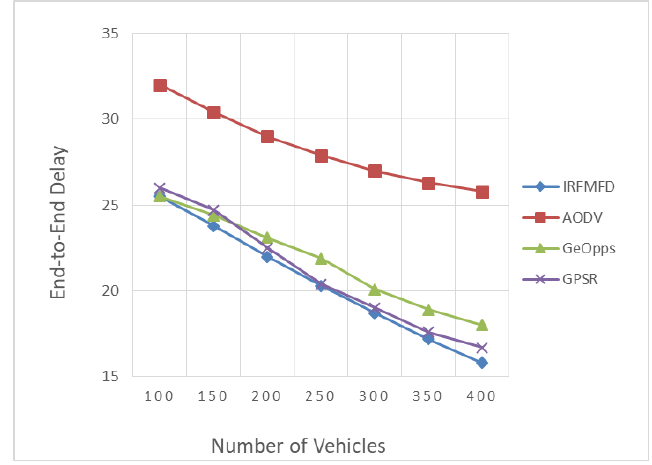
Figure 8. Average end-to-end delay with different numbers of vehicles .